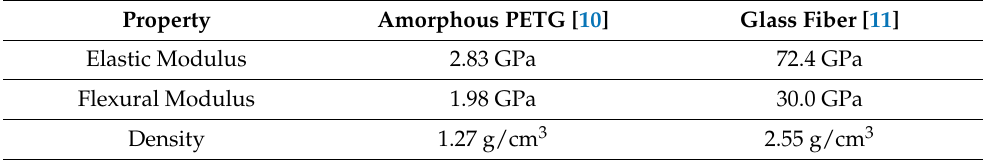
Table 1. Commingled roving constituent material properties.